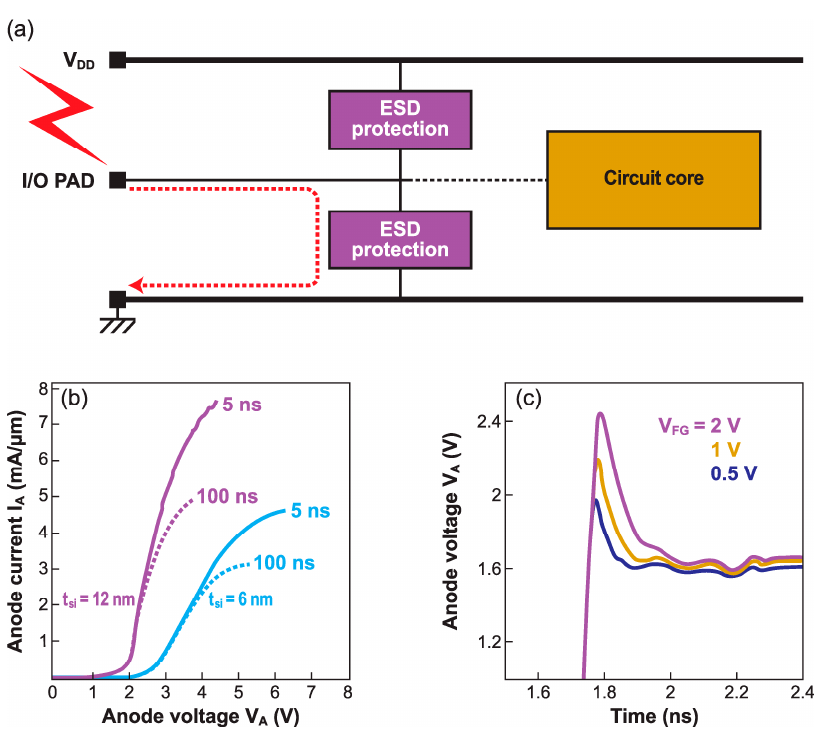
Figure 19. ( a ) Schematic ESD protection with a Z 2 –FET. ( b ) Output characteristics from TLP tests with long and short current pulses. ( c ) Anode voltage response in the very first nanoseconds after ESD strike showing the voltage overshoot (1 mA/ μ m current pulse with 55 ps rise time, adapted from [27,53]).